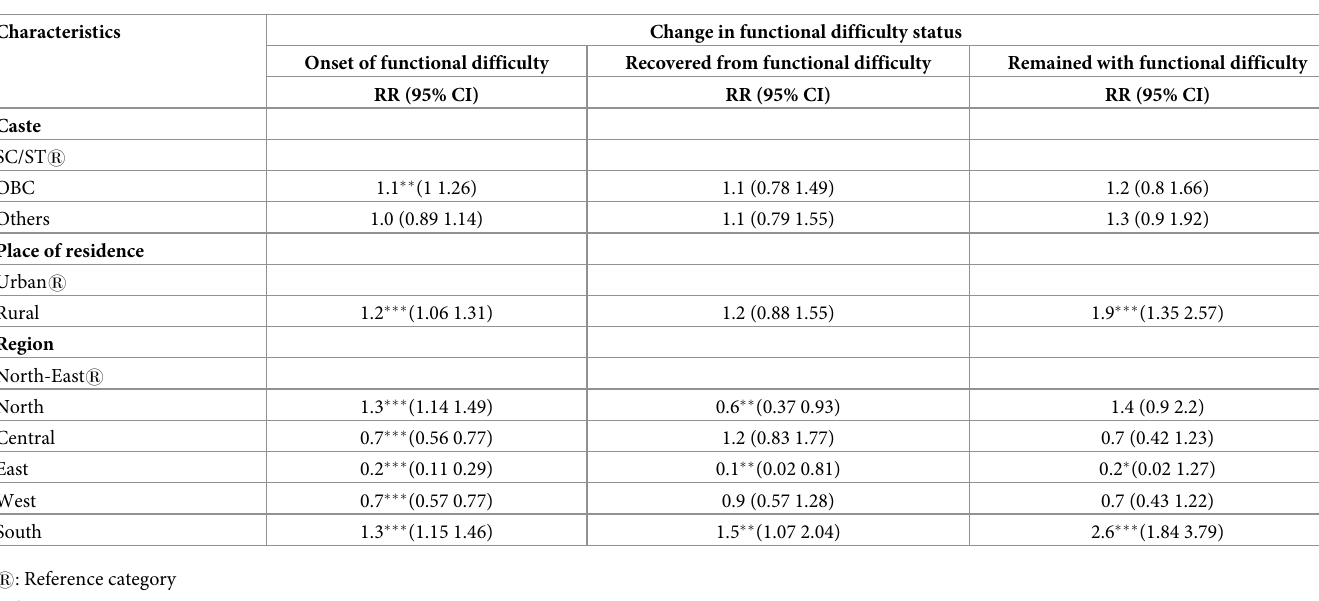
change in functional difficulty status by morbidity combinations during both the rounds. Hav- ing no functional difficulty in both rounds was taken as the base category, and having no mor- bidity combination was taken as the reference category for each morbidity combination. Participants with combination of diabetes and cataract were 1.6 times (RR: 1.6, CI: 1.1, 2.4) tion. Older adults with diabetes and heart disease were 3.2 times (RR: 3.2, CI: 1.3, 7.9)